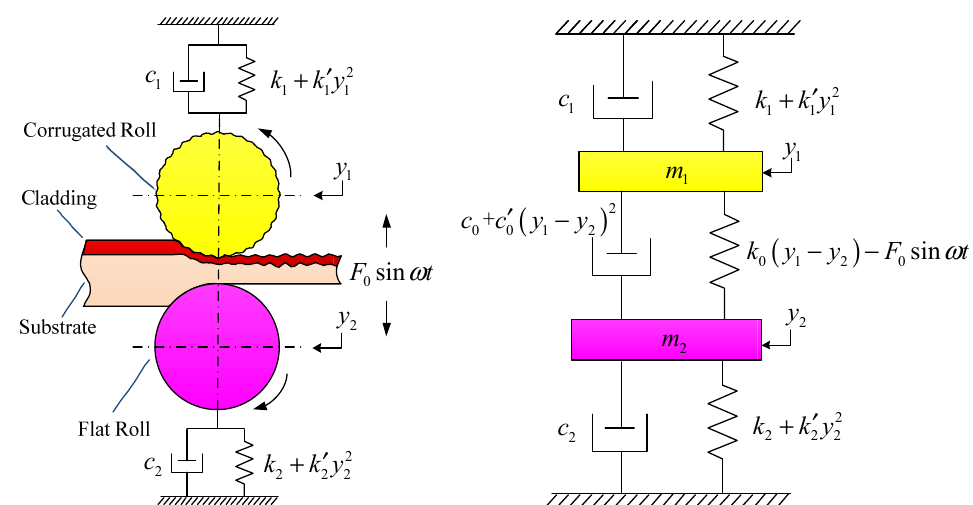
Figure 1. The rolling diagram of corrugated rolling mill: ( left ) the mechanical model; ( right ) two-freedom-degree vertical nonlinear vibration model.